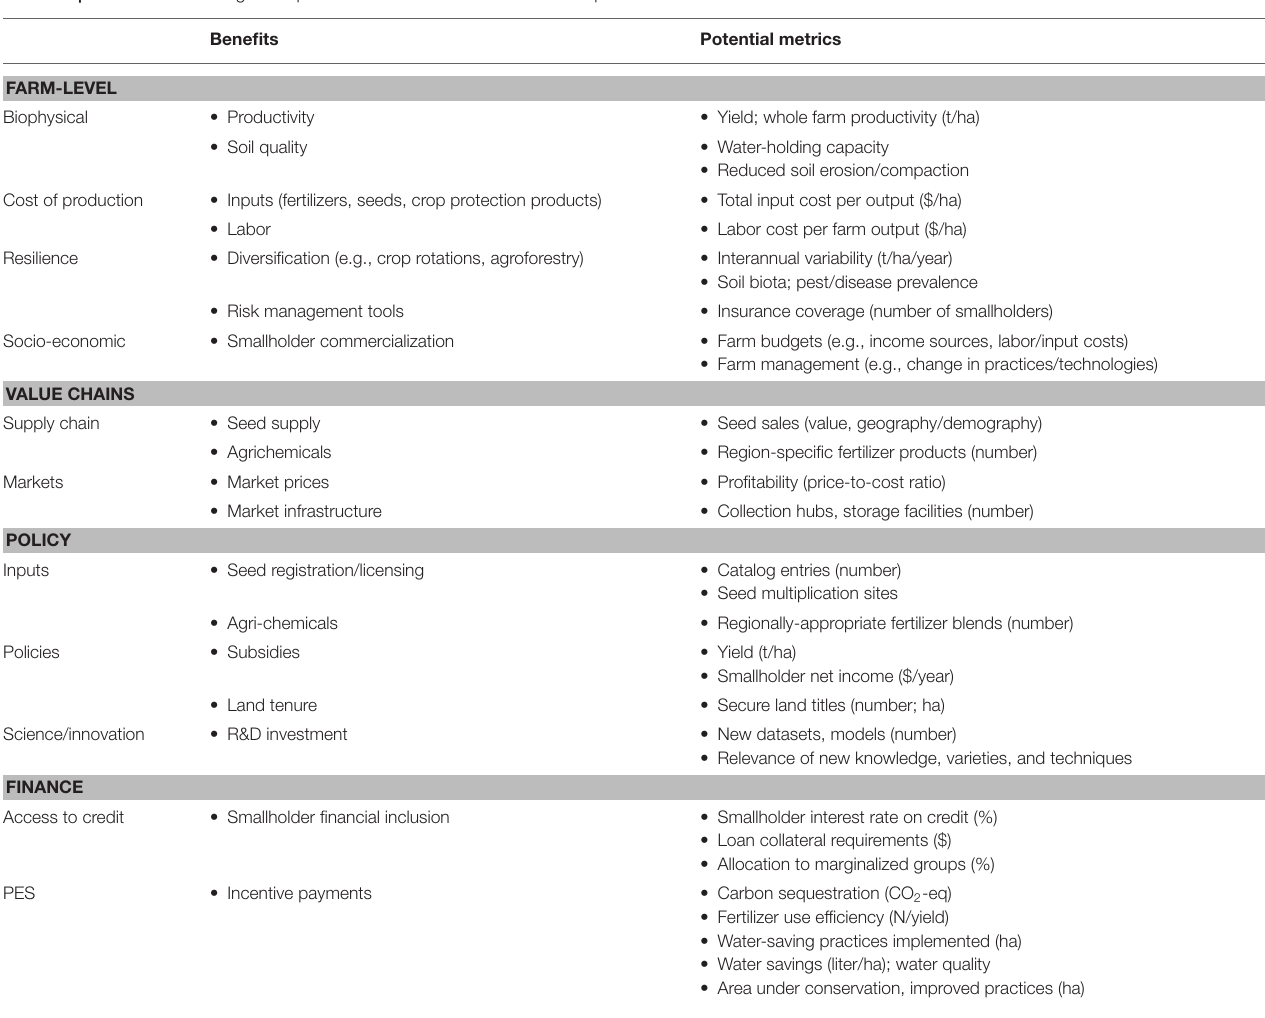
TABLE 3 | Metrics for assessing the impact of soil-related interventions at multiple